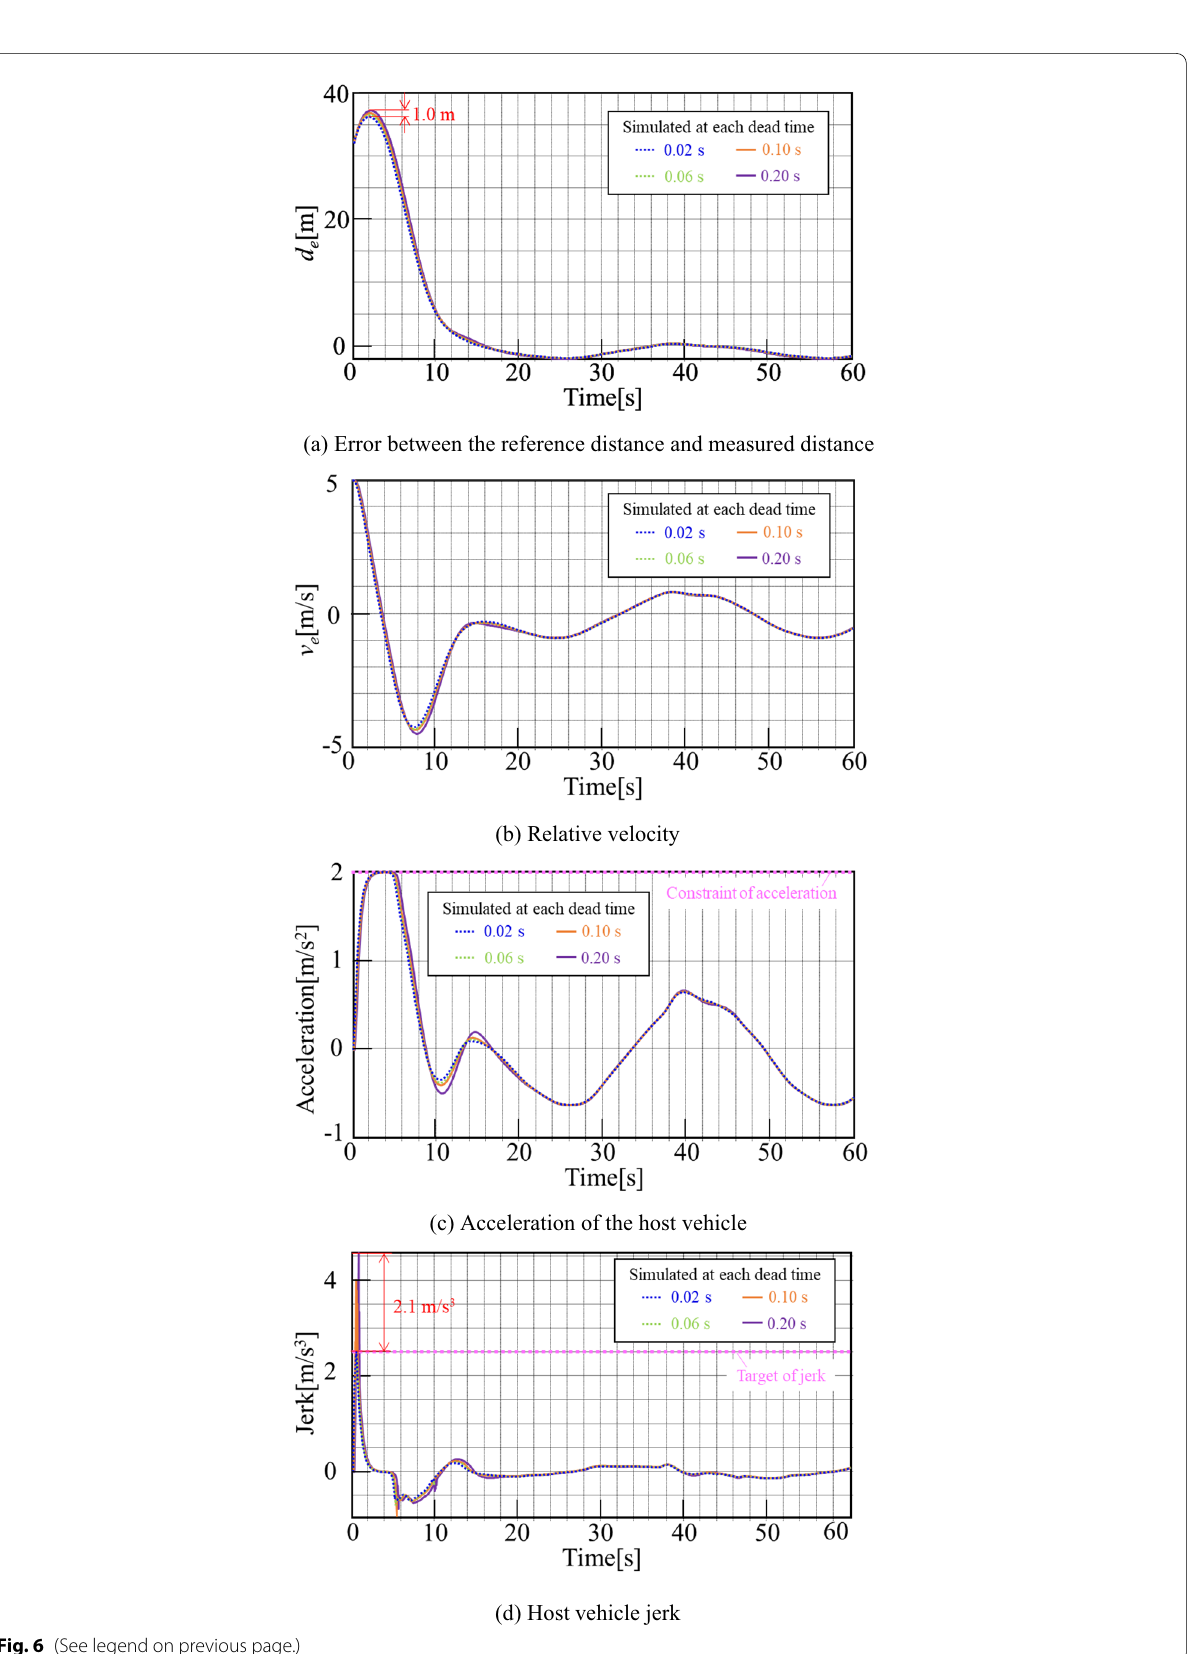
Fig. 6 (See legend on previous